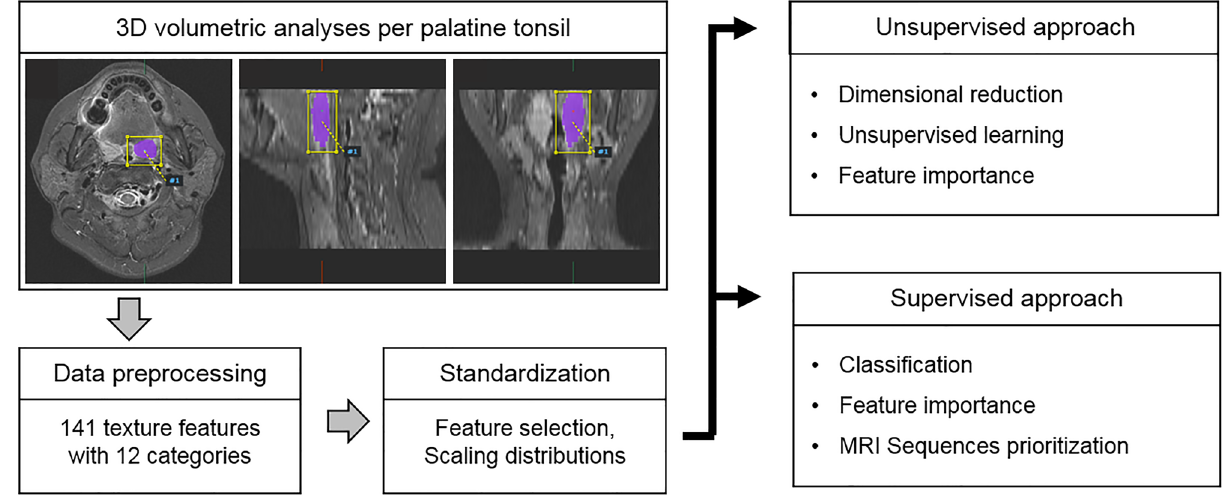
Figure 4. Workflow scheme of this study. Flow diagrams show the process from a VOI segmentation to model